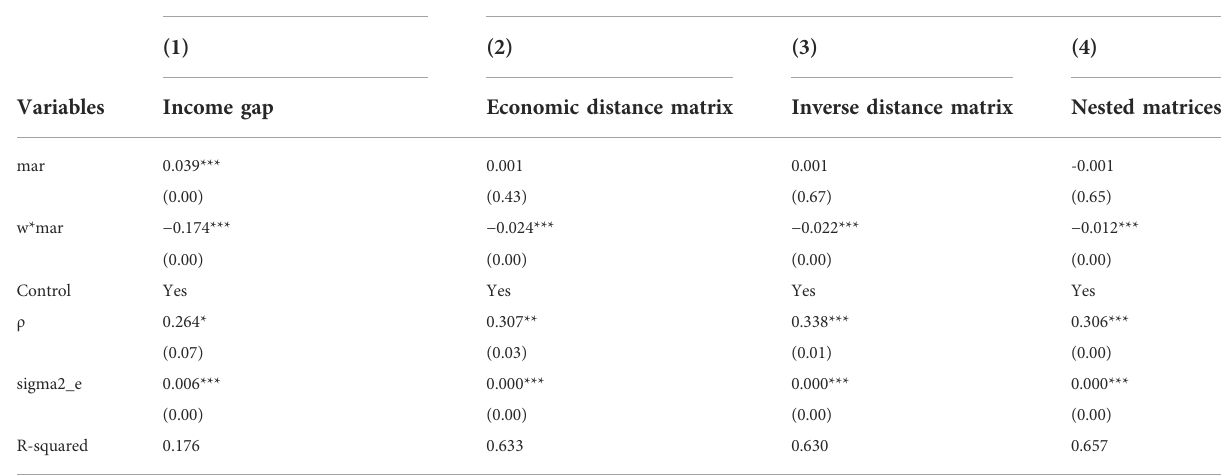
TABLE 8 Robustness